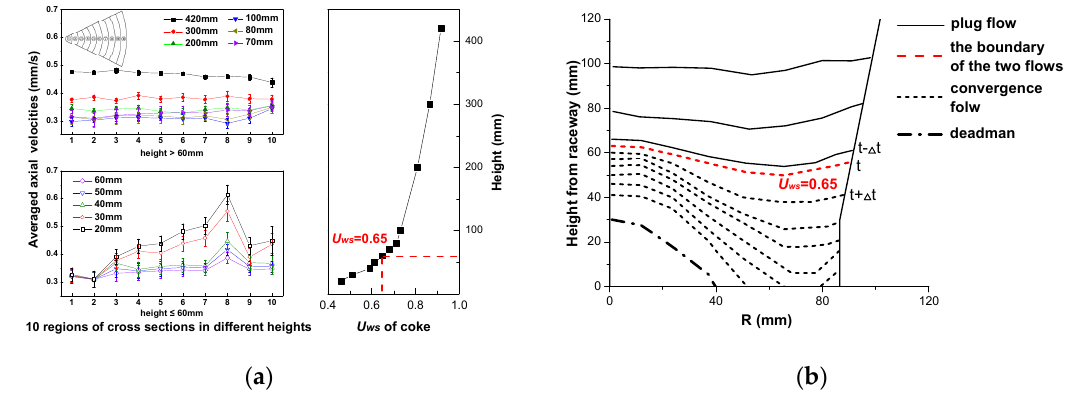
Figure 5. ( a ) Averaged axial velocity in 10 regions at different heights of the BF, and the ( U ws ) distributions along the height of the BF. ( b ) The boundary between the plug flow and convergence flow in the BF, which was determined by U ws .